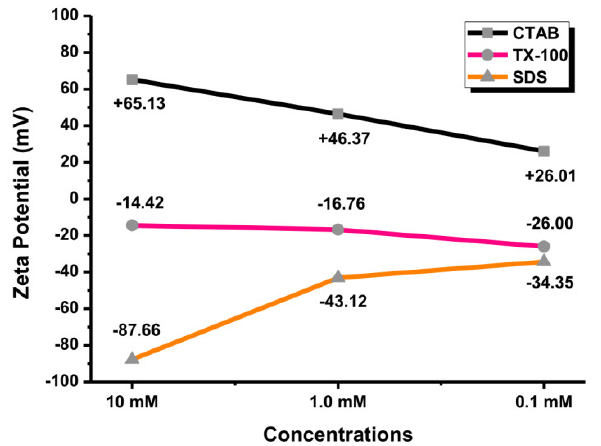
Figure 11. The zeta potential values of Au NPs with different concentrations of surfactants (0.1, 1.0, and 10 mM).